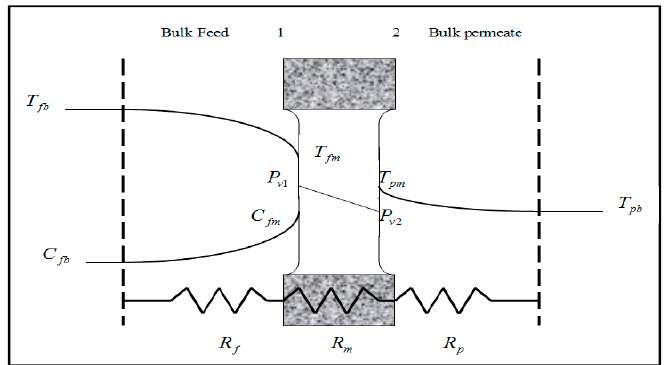
Figure 3. Concentration and temperature profiles in MD.